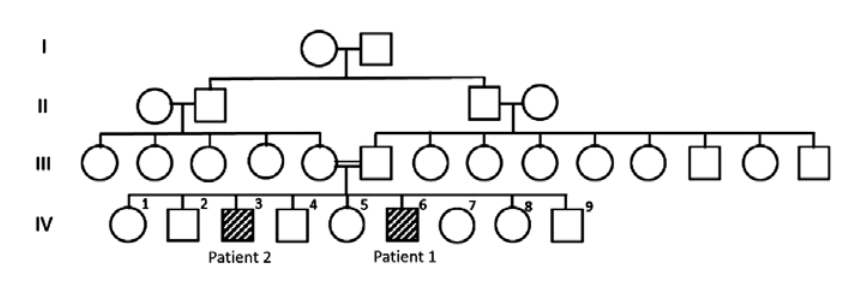
Figure 1. Family